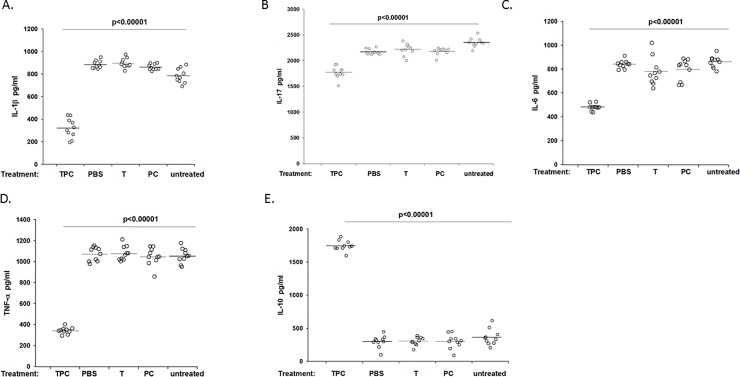
Cytokine expression by splenocytes from CIA mice.In vitro analyses of concentrations of the pro-inflammatory cytokines IL-1β, IL-17, IL-6, TNF-α, and the anti-inflammatory cytokine IL-10, in the culture fluids of splenocytes originating from tuftsin-phosphoryl choline (TPC), PBS, tuftsin (T), phosphorylcholine (PC) and untreated CIA mice. The data are presented as concentration in pg/ml. n = 10 per group. [A] In vitro analyses of the pro-inflammatory cytokine IL-1-β concentration. [B] In vitro analyses of the pro-inflammatory cytokine IL-17 concentration. [C] In vitro analyses of the pro-inflammatory cytokine IL-6 concentration. [D] In vitro analyses of the pro-inflammatory cytokine TNF-α concentration. [E] In vitro analyses of the anti-inflammatory cytokine IL-10 concentration.